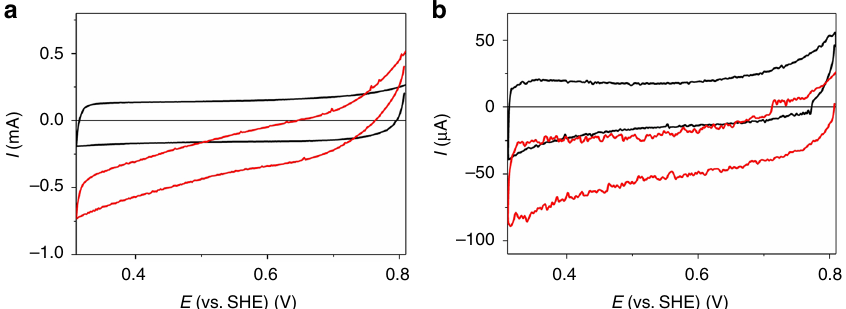
Fig. 4 Voltammetric characterization of the biocathode. a Cyclic voltammograms of a glucose oxidase/horseradish peroxidase modi fi ed carbon nanotube (CNT)/carbon micro fi ber (CMF)-carbon cloth electrode in presence of 50 mM glucose under argon (black line) and O 2 (red line) atmosphere; scan rate: 5 mV s − 1 . b Cyclic voltammograms of a pyranose oxidase/horseradish peroxidase modi fi ed CNT/CMF-carbon cloth electrode with O 2 bubbling through the electrolyte in absence (black line) and presence (red line) of glucose (1 mM). The geometrical surface area of the carbon cloth-based electrode was 1 cm 2